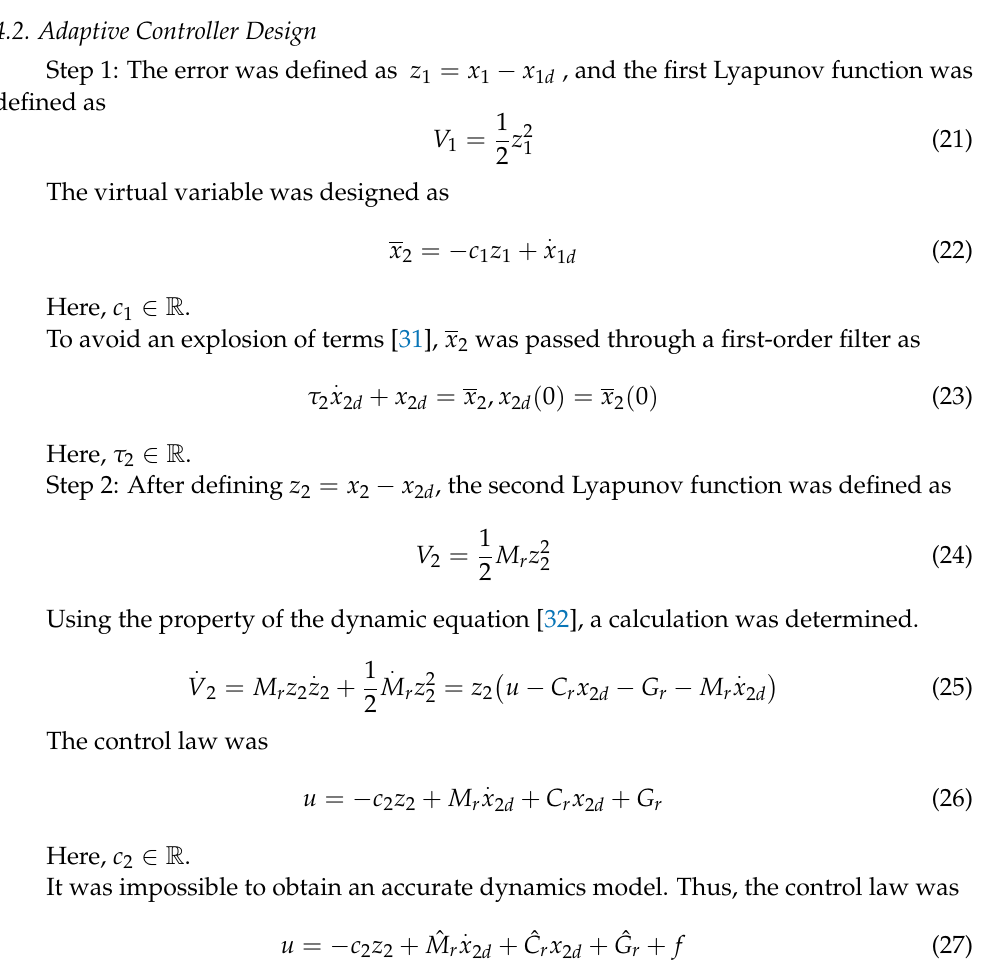
Figure 6. Mechanical structure and prototype of the knee exoskeleton.